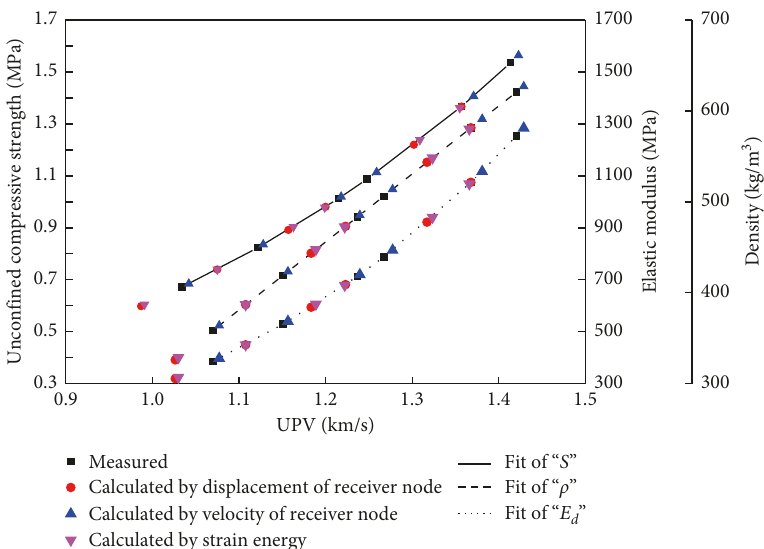
Figure 18: E d , S, and ρ versus UPV (comparison between experimental results and simulation results).